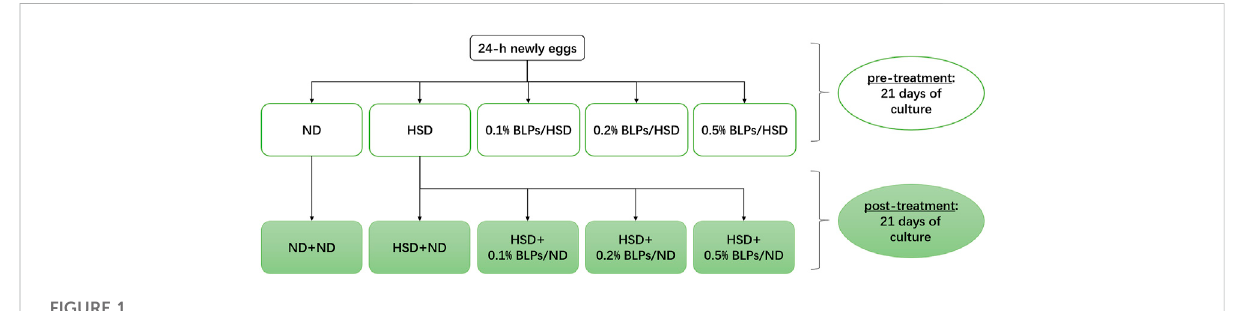
FIGURE 1 Experiment design of BLPs supplementation in two treatments.